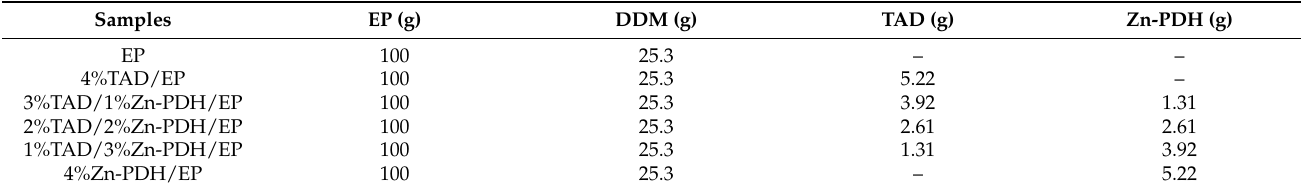
Table 9. Formulations of epoxy resin